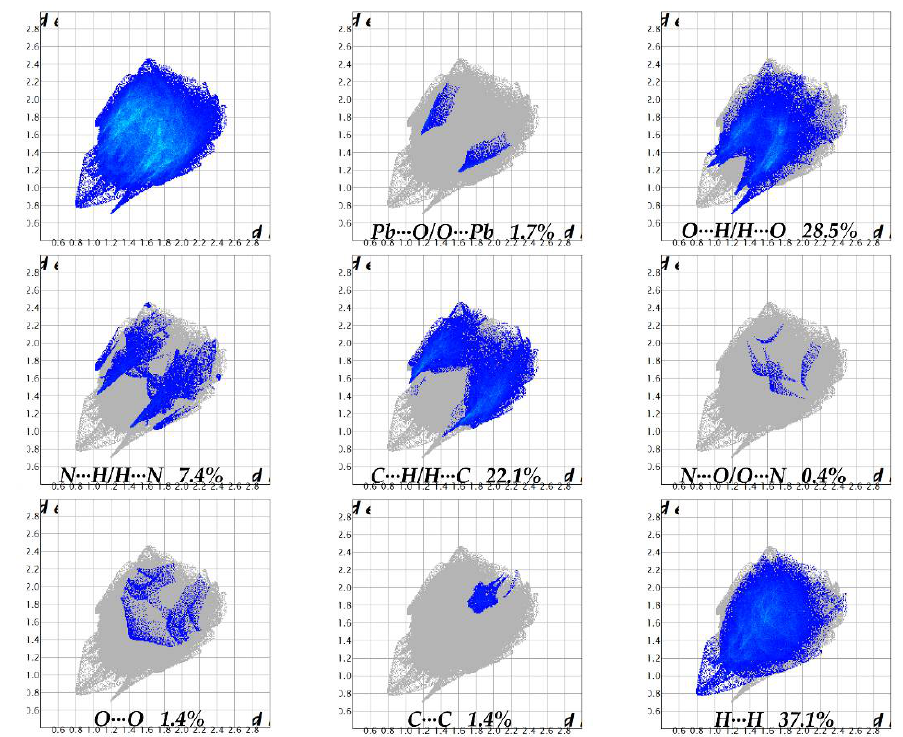
Figure 10. Full and decomposed fingerprint plots corresponding to various contacts involved within the structure of compound ( 2 ).